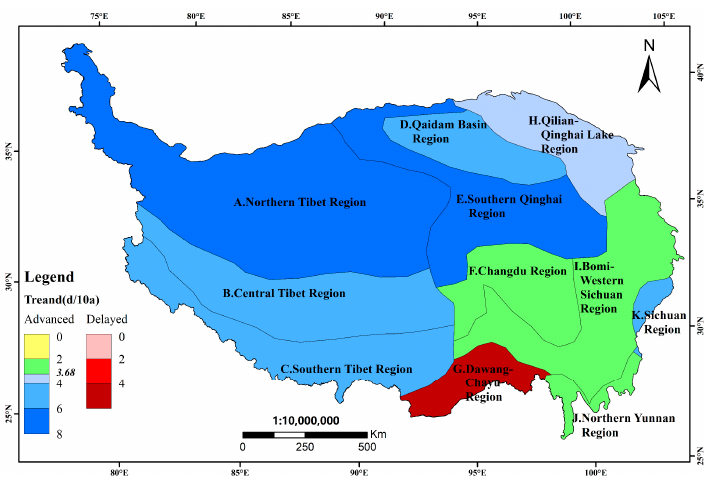
Figure 4. The differences in the trend in the rainy season onset for each region (1971–2015). Figure 4. The di ff erences in the trend in the rainy season onset for each region